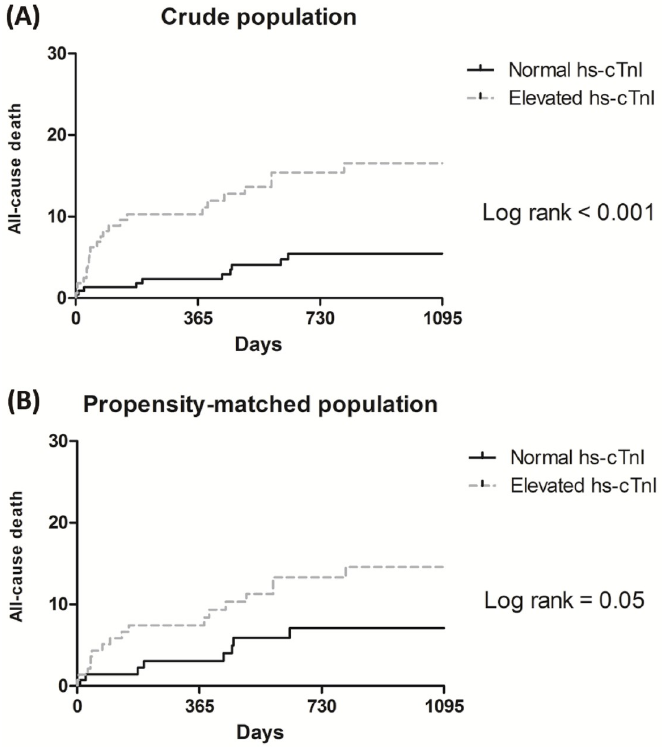
Fig 2. Kaplan-Meier curves for the groups in the overall population with elevated hs-cTnI and normal hs-cTnI levels. Curves for (A) the entire population and (B) the propensity-matched population.